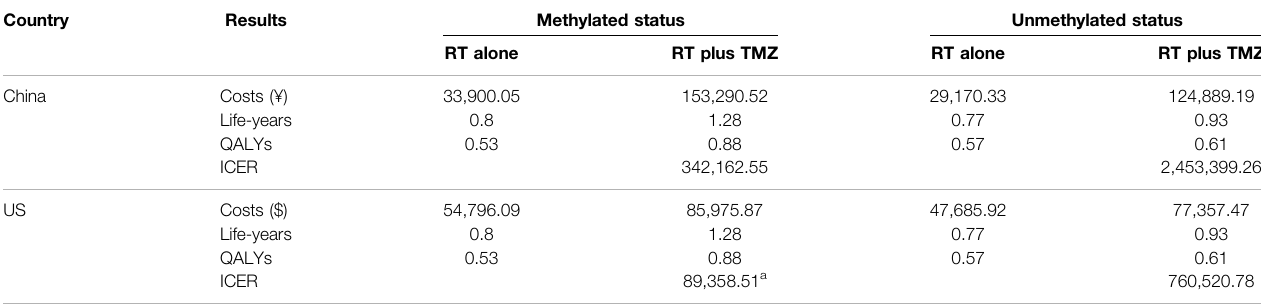
TABLE 3 | Costs and outcome results in the base case analysis. Country